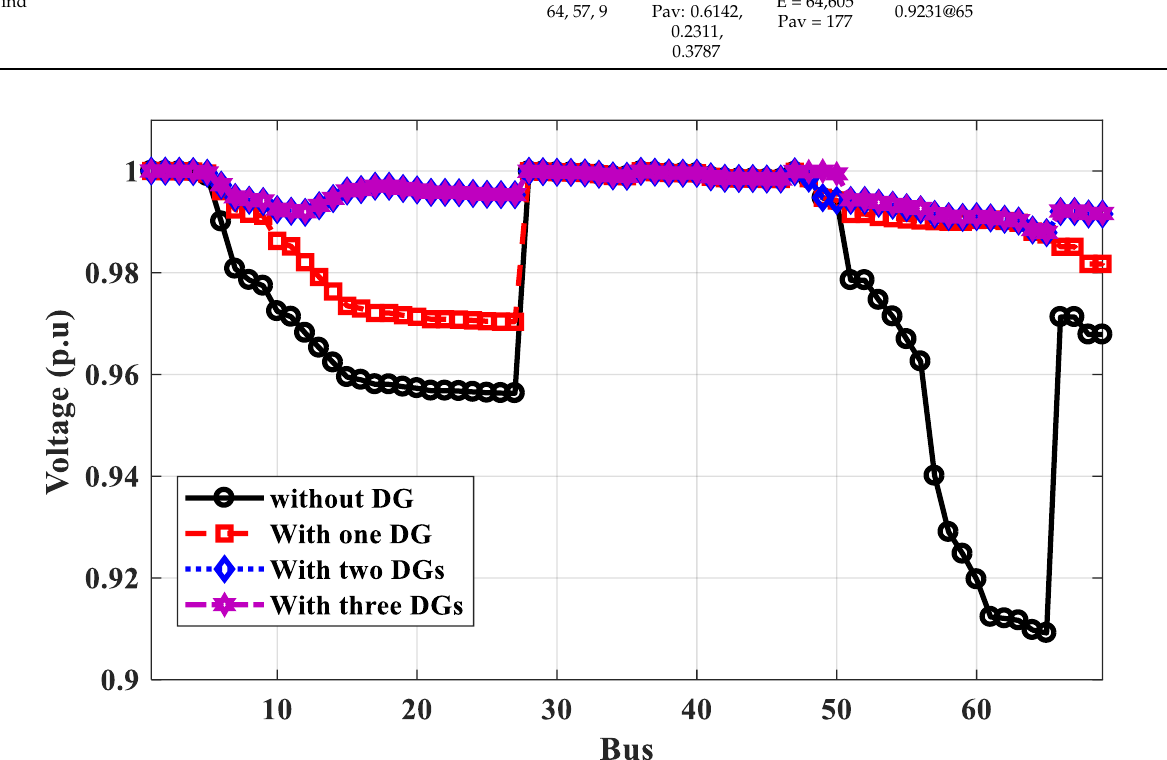
Figure 16. Voltage profile of IEEE 69-bus without and with DGs for power loss calculation.